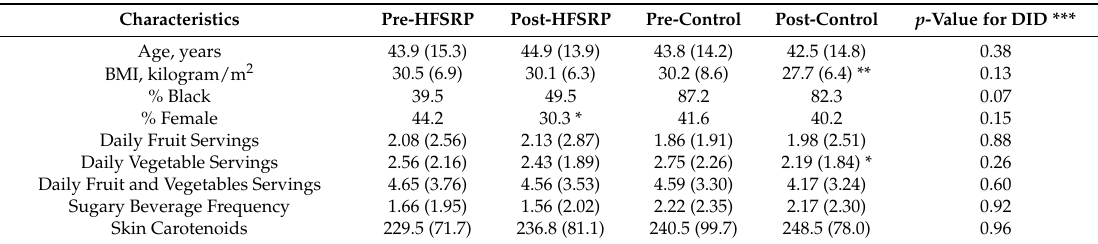
Table 3. Baseline ( n = 279) and follow-up ( n = 223) characteristics of customers. BMI: body mass index.